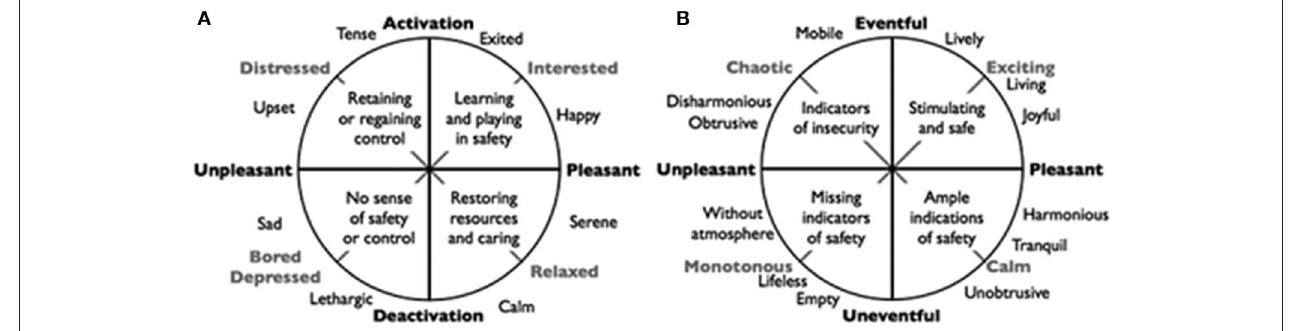
FIGURE 1 | Core affect and appraisal of auditory environments (from Andringa and Lanser, 2013, CC-BY). (A) Core effects. (B) appraisal.